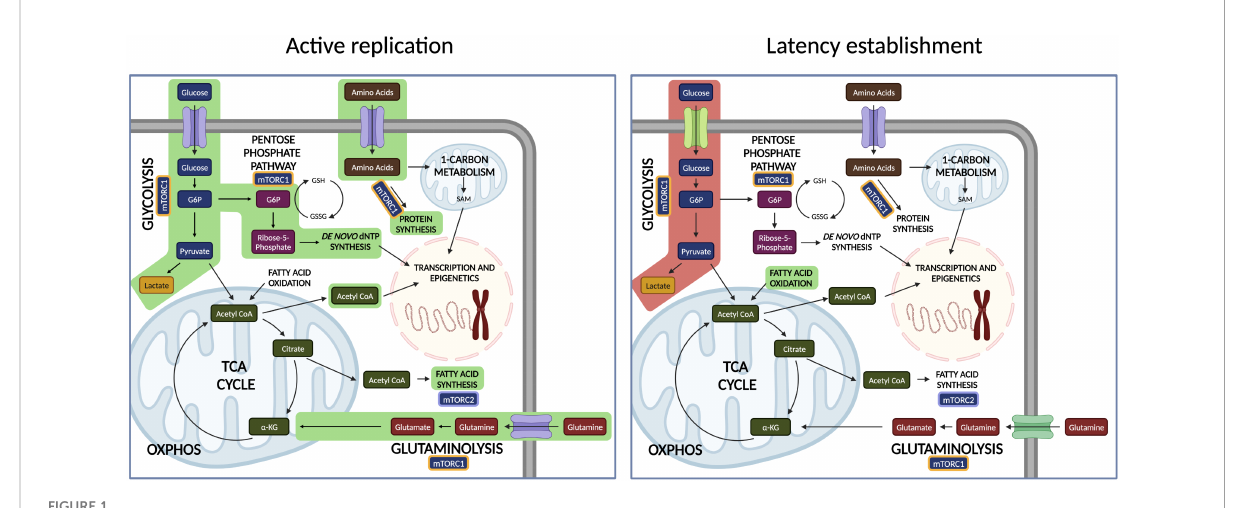
FIGURE 1 Metabolic pathways are differentially regulated in HIV-1 active replication and latent infection. During active replication, the infected cell must increase glucose and amino acid uptake to support normal anabolic functions in addition to virion production. During the establishment of latency, the cell progressively downregulates aerobic glycolysis. Decrease in mTORC1-dependent pathways reduces virions production. Pathways highlighted in green represent upregulation, while pathways highlighted in red represent